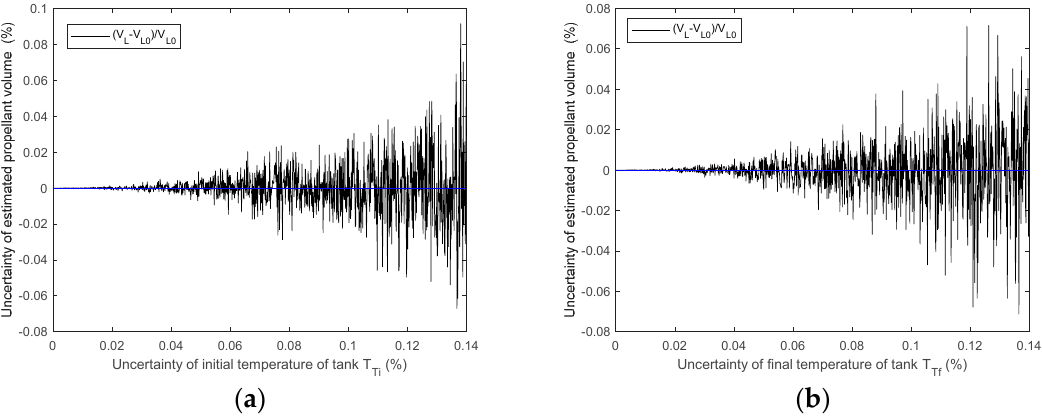
Figure 4. Effect of the temperature accuracy in the tank on the final measuring uncertainty (( a ) is of the initial temperature of the tank, and ( b ) is of the initial temperature of the tank).